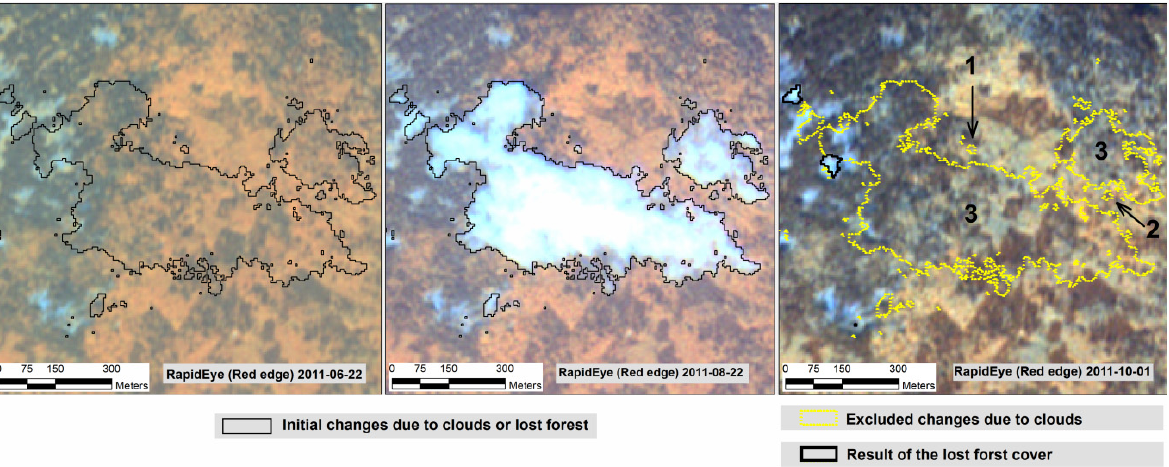
Figure 3. Example of how additional data from an additional Rapid Eye (RE) image were used to overcome the problem of the presence of clouds in two RE images used for change detection analysis. Initial analysis of the changes between an image from 22 June/12 July ( left ) and one from 22 August ( middle ) indicated differences, which were actually due to either clouds or lost forest. Additional data from the image from 1 October ( right ) facilitated the exclusion of those changes due to clouds and produced the final results showing the actual losses in forest cover, by implementing (1) first criterion; (2) second criterion; and (3) third